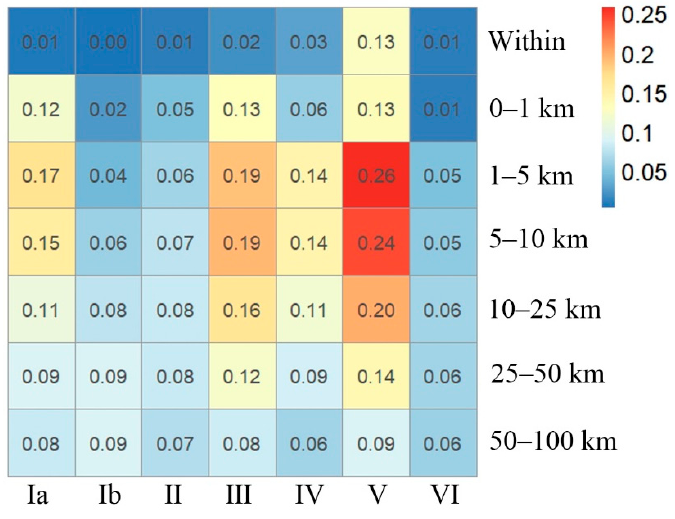
Figure 11. Trends within every type of PAs and of buffers.